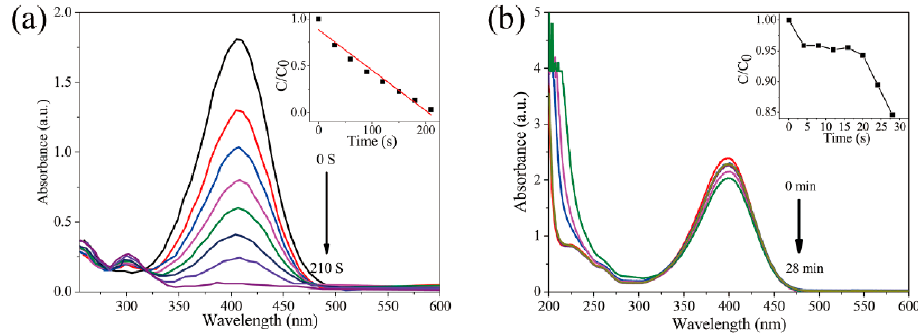
Figure 8. Successive UV-vis absorption spectra of the NaBH 4 reduction of 4-nitrophenol catalyzed by TiO 2 /Aphen ( a ) and pure TiO 2 ( b ).